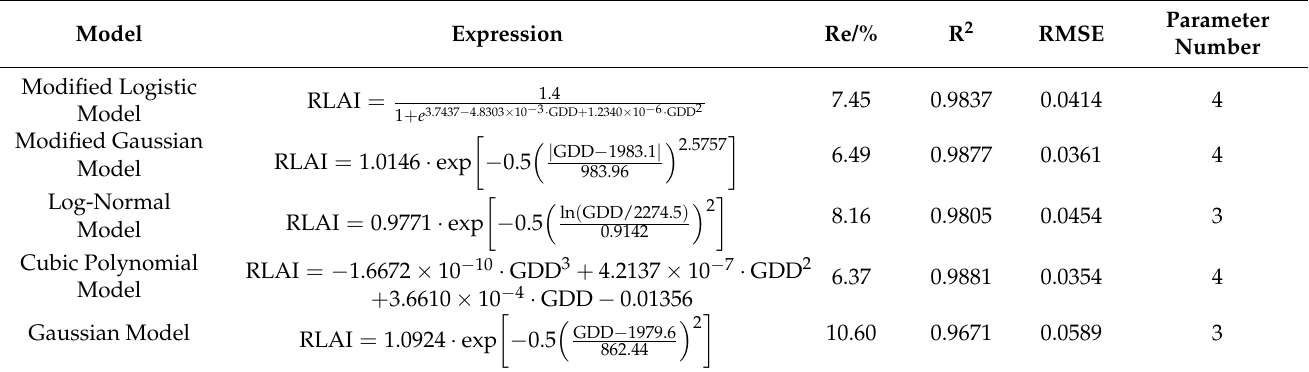
Table 3. Fitted values and simulated errors of five leaf area index growth models. Re is the relative error, R2 is the coefficient of determination, and RMSE is the root-mean-square